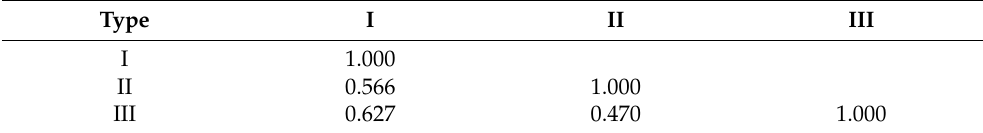
Table 4. Correlations.